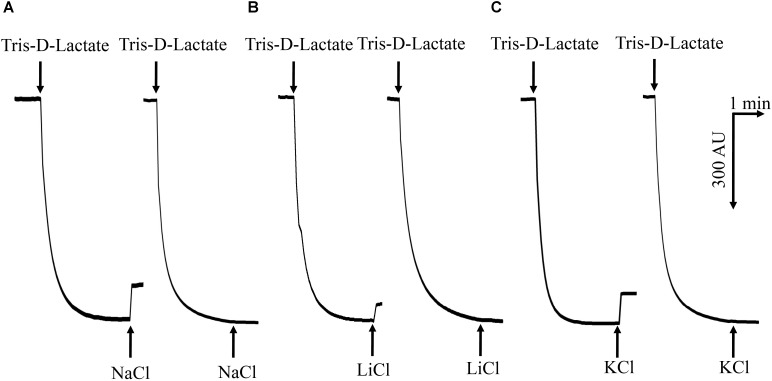
Assay for Na+(Li+, K+)/H+ antiport activity in the everted membrane vesicles. Na+/H+ antiport (A), Li+/H+ antiport (B) and K+/H+ antiport (C) activities were measured in everted membrane vesicles prepared from cells of E. coli KNabc/pET22b-PRO-RDD (to the left) or KNabc/pET22b (to the right) by the French pressure cell method. The highest activity at pH 9.0 were shown as the representatives of each of them. At the time points indicated by downward arrows, Tris–D-lactic acid (final concentration at 10 mM) was added to the assay mixture to initiate fluorescence quenching. At the time points indicated by upward arrows, NaCl (final concentration at 10 mM), KCl (final concentration at 10 mM), or LiCl (final concentration at 10 mM) was added to the assay mixture. Fluorescence quenching is shown in arbitrary units.